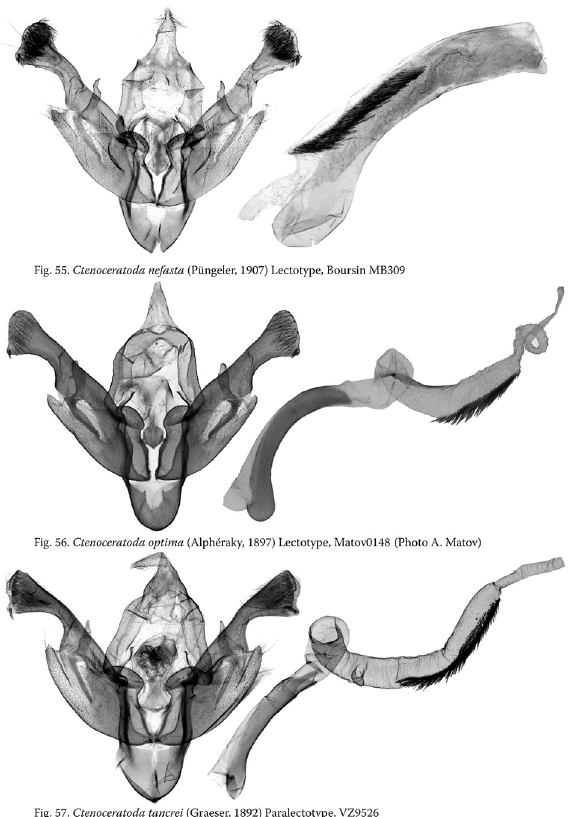
Figure 55–57. 55. Ctenoceratoda nefasta (Püngeler, 1907) Lec- totype male. 56. Ctenoceratoda optima (Alphéraky, 1897) Lec- totype male. 57. Ctenoceratoda tancrei (Graeser, 1892) Para- lectotype male.